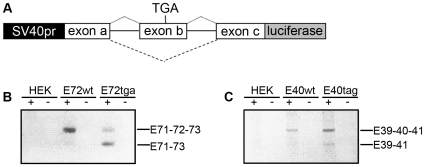
Splice forms and spontaneous exon skipping of DMD minigene reporter constructs in HEK 293 cells.(A) Schematic of DMD minigene luciferase reporter gene constructs. A genomic segment of human or mouse DMD containing three exons (a, b, and c) and their intervening introns (solid lines) was cloned downstream of the SV40 promoter and in-frame with the luciferase coding sequence of the pGL3 vector. Dotted lines represent splicing of full-length transcript and dashed lines that of the exon skip transcript. Variations of each construct were made containing stop codon mutations in exon b, as indicated by TGA. (B) RT-PCR products with primers spanning DMD exon 71 to luciferase (marked + or − for with and without reverse transcriptase enzyme) from untransfected HEK 293 cells or cells transfected with the hE72-Luc construct with (tga) or without (wt) a TGA stop codon mutation, showing spontaneous exon skipping that is enhanced upon addition of a nonsense mutation. (C) RT-PCR products with primers spanning DMD exon E39 to luciferase from untransfected HEK 293 cells or cells transfected with the hE40-Luc construct with (tag) or without (wt) a TAG stop codon mutation show the same effect, although less dramatic.